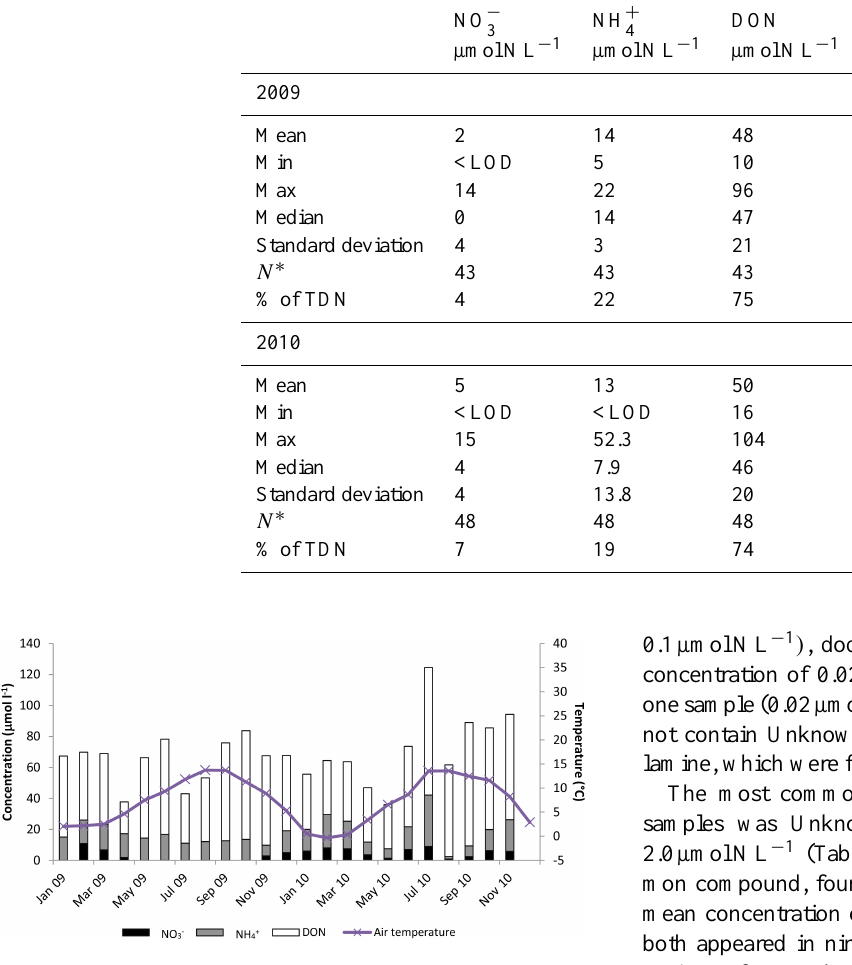
Figure 4. Discharge-weighted monthly mean concentrations of NH + (grey), NO − (black) and DON (white) in stream water. The 4 3 line represents mean monthly air